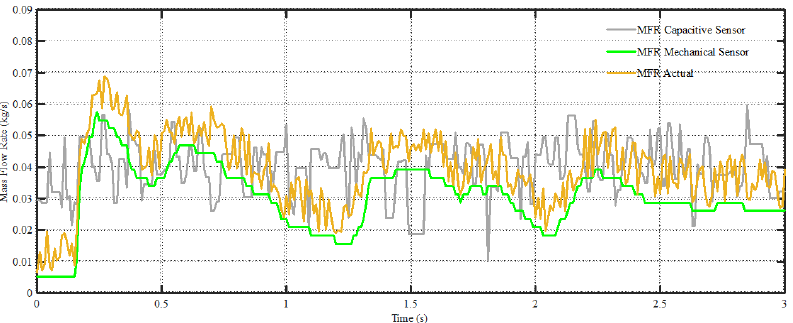
Figure 17. MFR from the electrical sensor, mechanical sensor, and actual value.